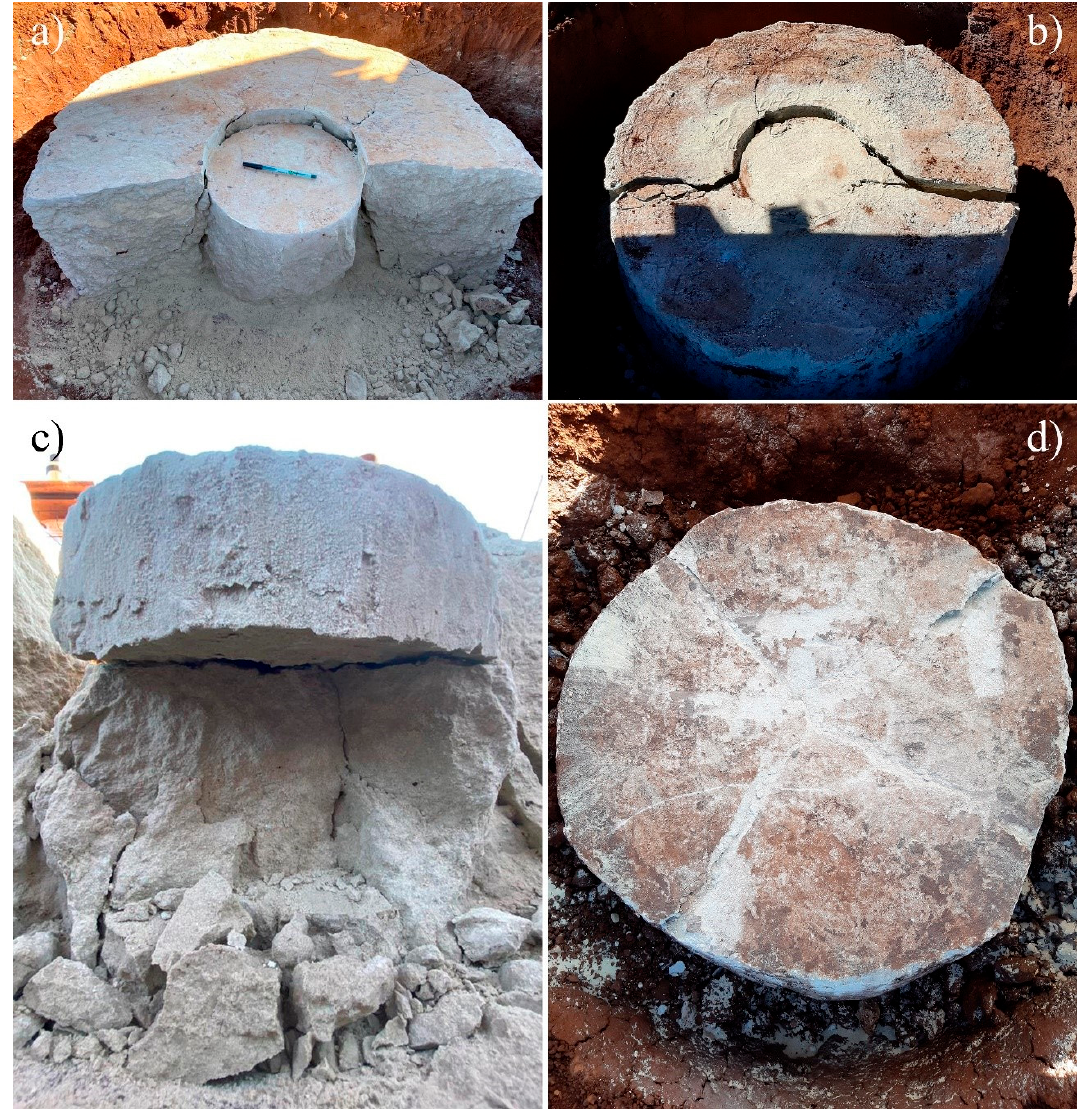
Figure 15. D r 900 mm B SHS and B H2O stabilized layers exhumed from the soil; ( a ) cutting the layers to identify cracks; ( b ) identification of external cracks; ( c ) cracks in the center of the layer underneath the foundation; ( d ) cracks in the top layer.